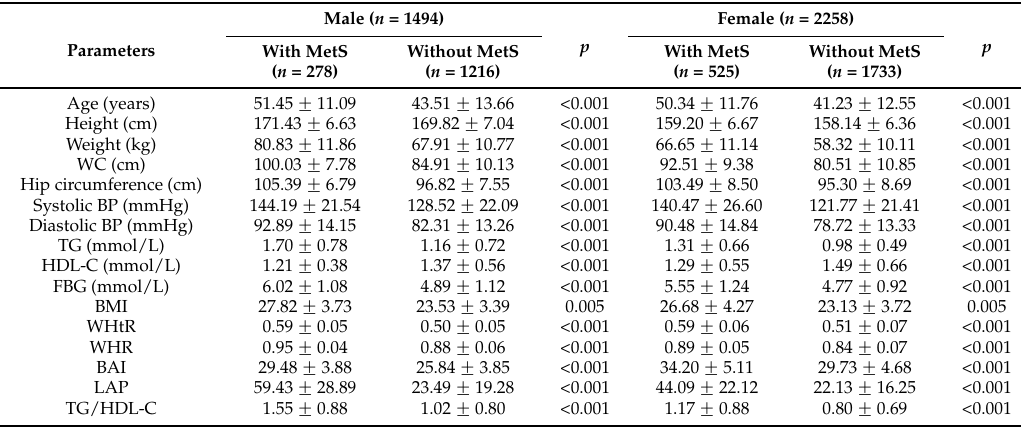
Table 1. Baseline characteristics of the study population according to the International Diabetes Federation (IDF)